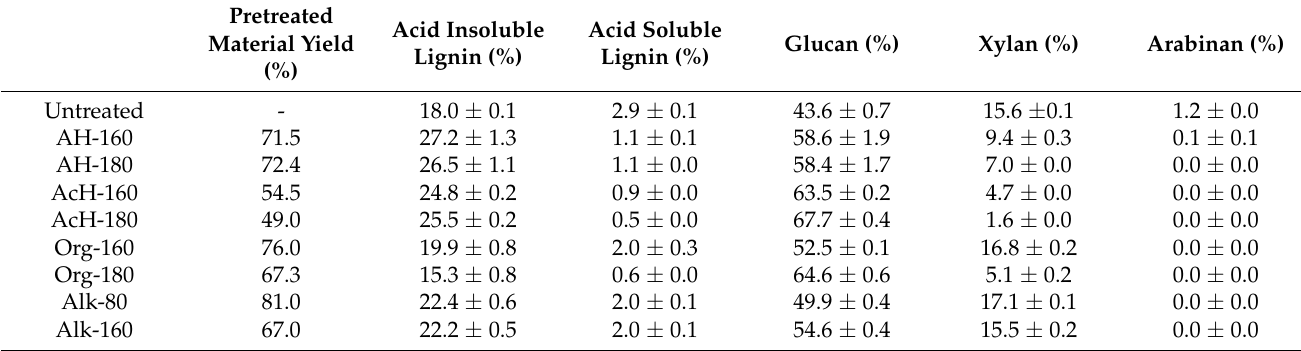
Table 2. Yield and chemical composition of the pretreated materials (WIS fraction).